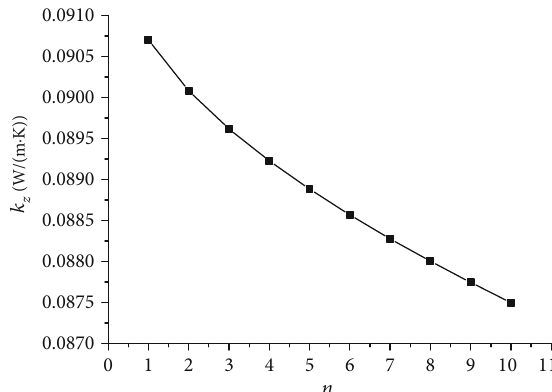
Figure 9: Variation of equivalent thermal conductivity with the number of